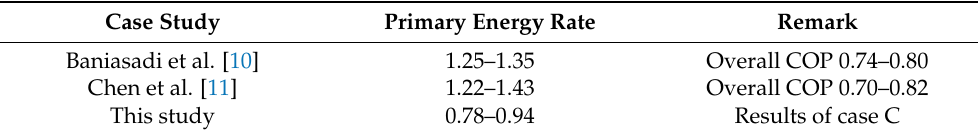
Table 4. Comparison of primary energy rate of tri-generation